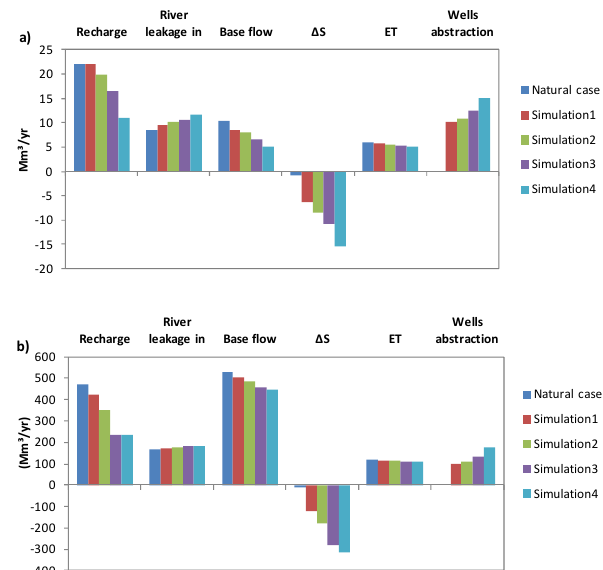
Figure 13. Water balance components of 4 simulation scenarios for (a) White River and (b) whole